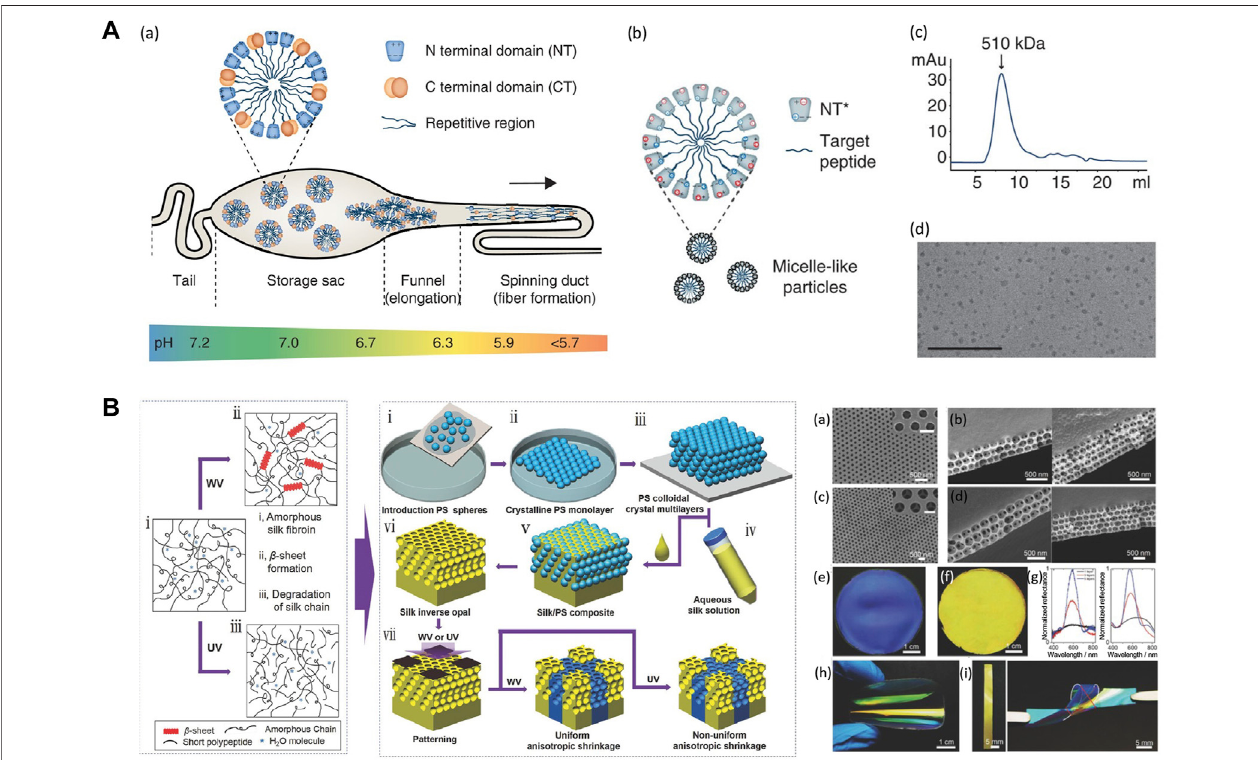
FIGURE6| Materialprocessingstrategiesonsilk-basedmaterials. (A) Designofthespidersilkspinningsystems. (A) Spidroinsaresynthesizedinthetailregionand stored in the storage sac where pH = 7.0. Proteins form micelles to prevent premature aggregation. The hydrophilic NT domains have dipolar charge distribution, represented by + and - symbols. Spidroins are self-assembled when going through the spinning duct due to the pH changes and shear forces. (B) NT can be used as a fusiontagtomediateproteinsolubilityandprotecthydrophobicregionsfromaqueoussolutions.ThespidroinswithmutantNT*canadjustsolubilityoverawiderpH range based on the reduced dipolar charge distribution of NT* than NTwt. (C) Size exclusion chromatography shows puri fi ed amphiphilic fusion protein form 510 kDa assemblies. (D) TEM image shows that spidroins micelle-likeparticlesare around 10 – 15 nm in size. Adapted with permission from ref(Kronqvist et al., 2017).Copyright 2017 Springer Nature. (B) Fabrication of silk inverse opals. Using colloidal crystals composed of PS spheres as SIOs templates, SF solution was in fi ltrated into PS SIOs templates and allowed to dry. The resultant silk/PS composite fi lm was immersed into toluene to dissolve the PS substrate. Patterned silk inverse opals are formed after treating with water vapor (WV) and UV light. The diameters of PS templates were 210 nm and 300 nm. Adapted with permission from ref (Wang et al., 2017). Copyright 2017 WILEY-VCH.